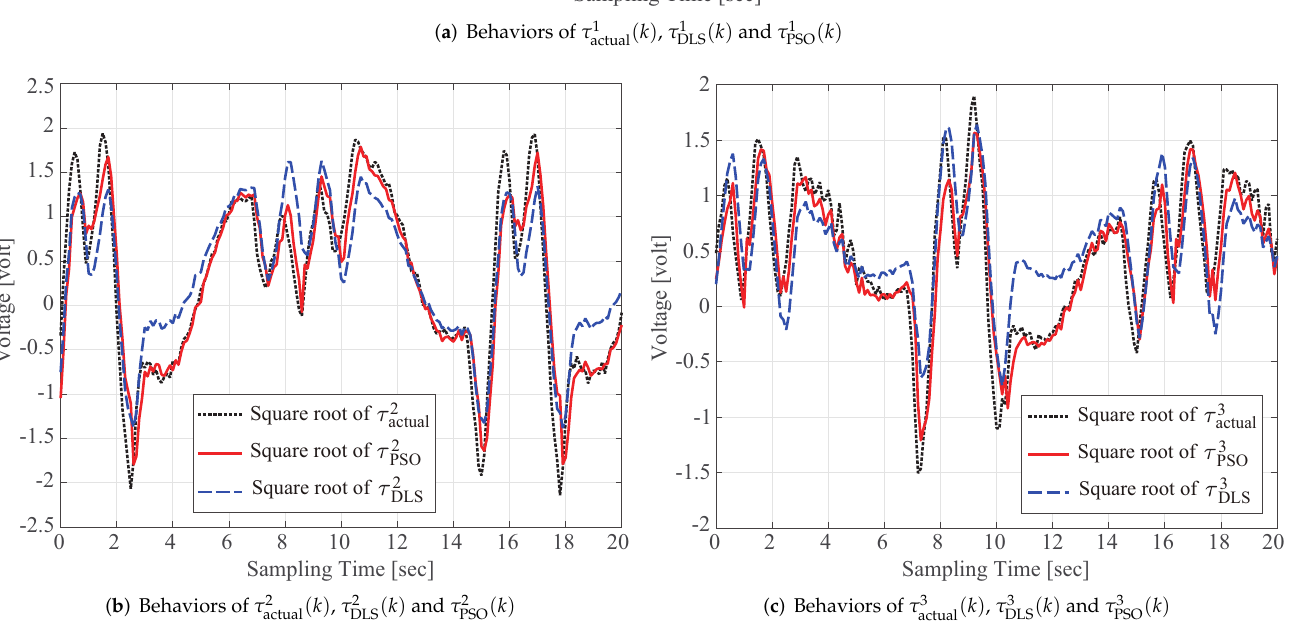
( k ) obtained from DLS ( k ) computed using (26) with PSO